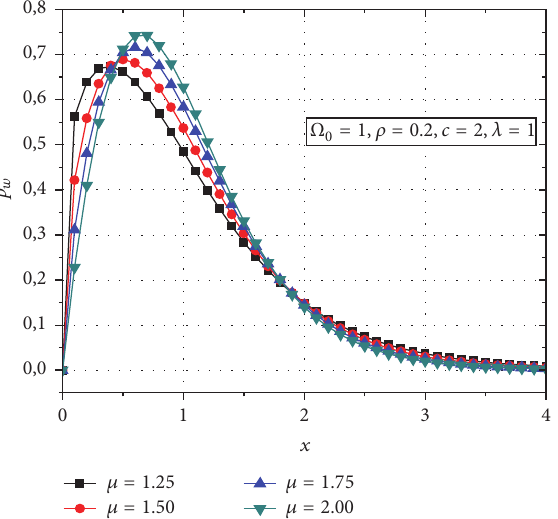
Figure 2: Probability density function of microdiversity MRC receiver.